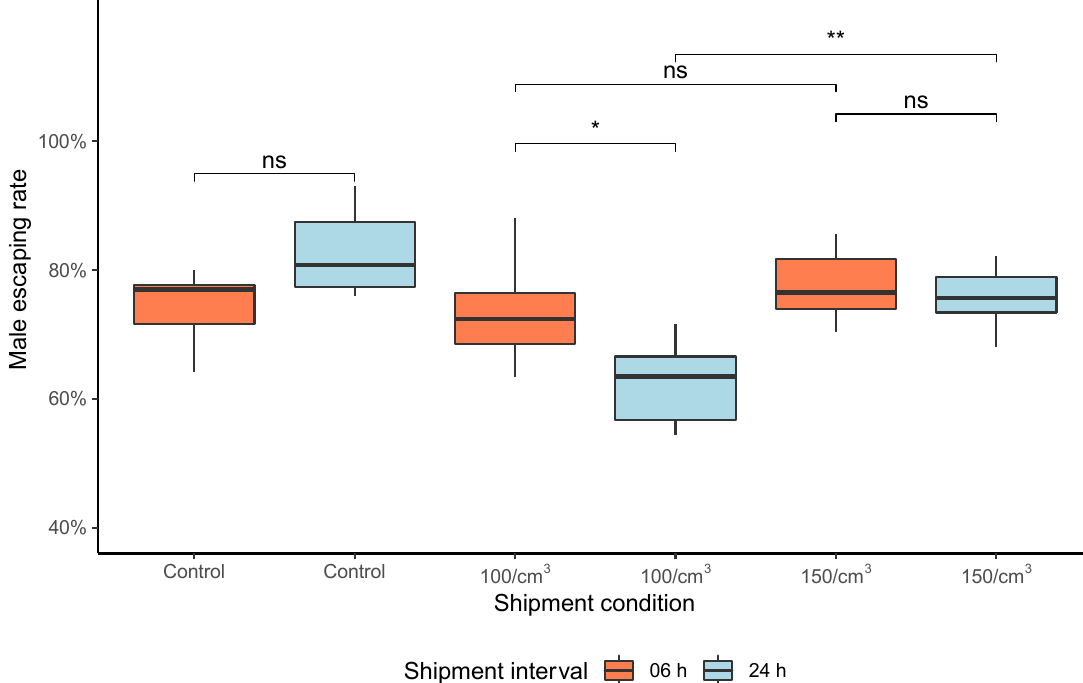
Figure 6. Escape rates of male Aedes mosquitoes after knockout (4 ◦ C for 60 min), compacted (100 and 150 males/cm 3 ), and transported (for 6 and 24 h at 10 ◦ C). Significant differences between treatment groups are indicated by the p -value level. The boxplot shows the median and upper and lower quartiles. Significance values goes as ‘**’ < 0.01, ‘*’ < 0.05, ‘ns’ < 0.1. Regarding the physical damages, less than 2% of mosquitoes had damaged their wings after exposure to both compaction densities for 6 and 24 h at 10 ◦ C (Figure 7A) without a statistical difference found between the densities for each shipment interval. Observations lead to a higher wing damage percentage for both compaction densities in more extended shipment periods (100 males/cm 3 with Wilcoxon–Mann–Whitney = 12.5; p = 0.015 and 150 males/cm 3 with Wilcoxon–Mann–Whitney = 12; p = 0.013). Less than 1% of compacted mosquitoes had broken legs (Figure 7B), without any statistical difference between densities (100 males/cm 3 with Wilcoxon–Mann–Whitney = 38.5; p = 0.930 and 150 males/cm 3 with Wilcoxon–Mann–Whitney = 35; p = 0.690) or shipment periods (6 h with Wilcoxon–Mann– Whitney = 50; p = 0.410 and 24 h with Wilcoxon–Mann–Whitney = 46; p = 0.630). In contrast, the densities had an increased number of males with severe scale loss after 6- and